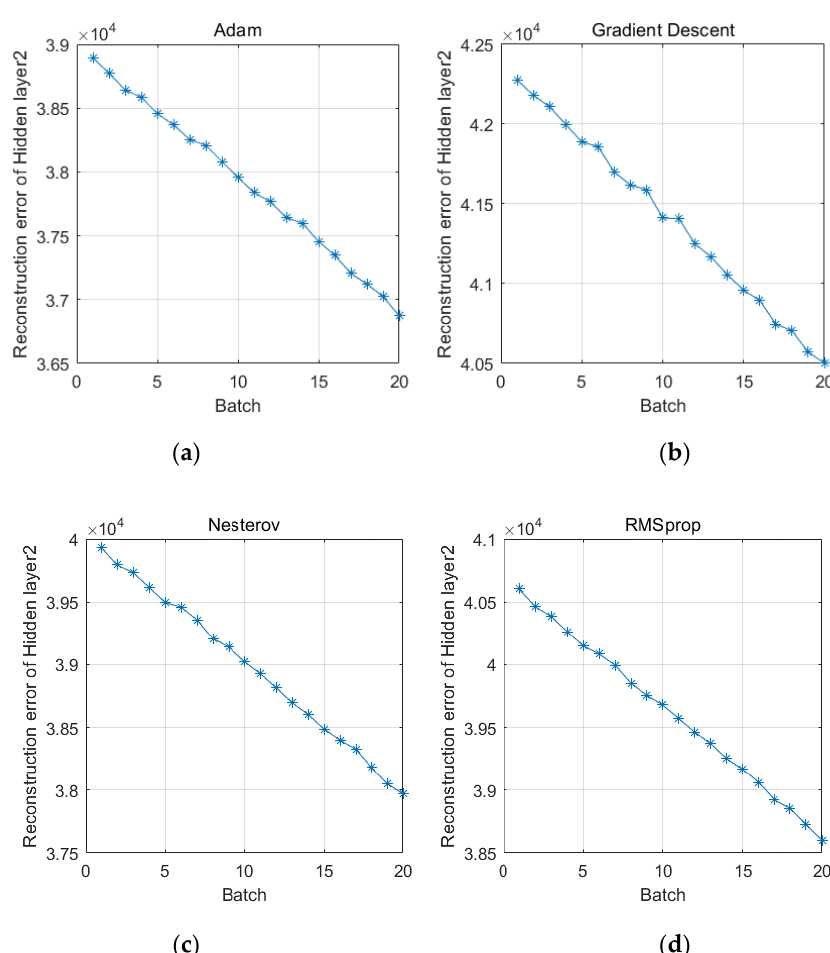
Figure 14. Comparison of second-layer reconstruction error when training the CDBN with different optimizers: ( a ) Adam, ( b ) Gradient Descent, ( c ) Nesterov, ( d ) RMSprop.